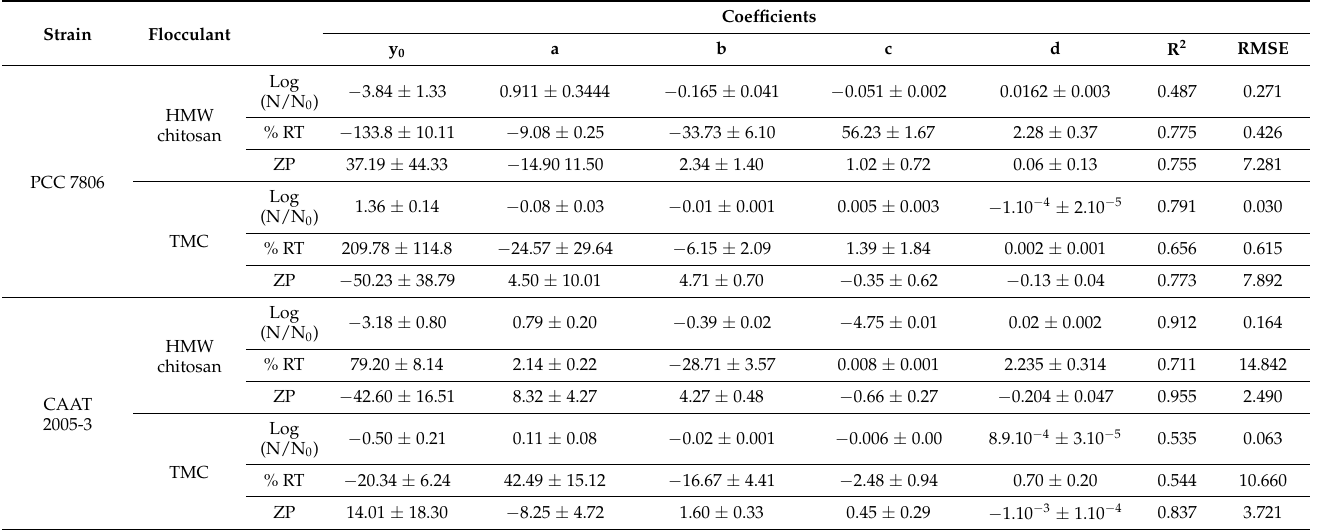
Table 1. Coefficients determined by regressions using response surface methodology (RMSE) for each analyzed response and statistical parameters (determination coefficient (R 2